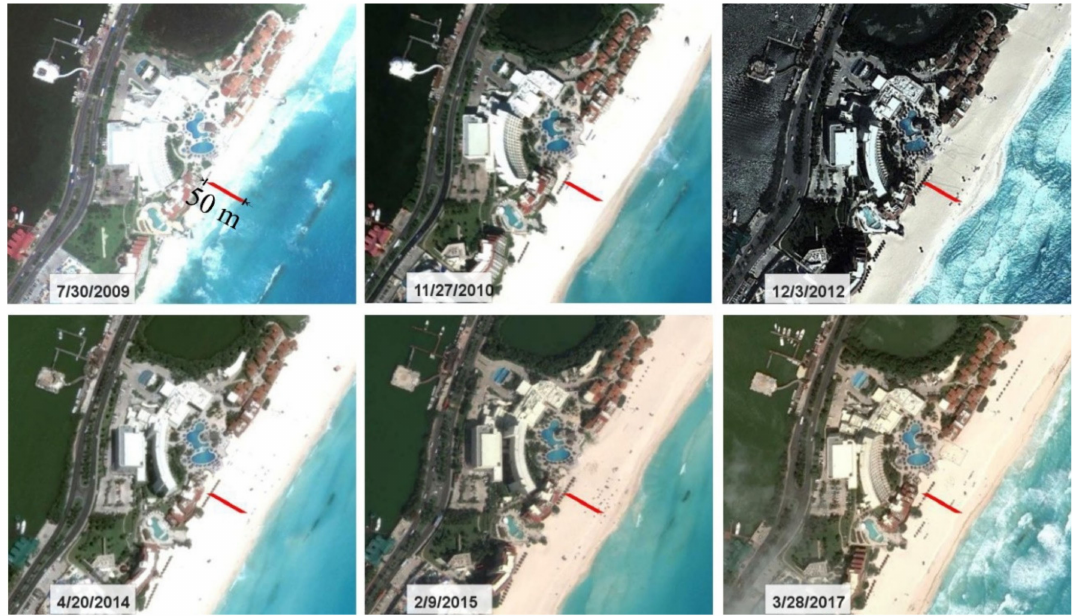
Figure 14. Satellite images, 2009 to 2017, of the beach in front of the Grand Park Royal Cancun, located in the central-north part of the beach (source: Google Earth Pro, version: 7.3.2.5776). The red line, 50 m long, shows the dynamic stability being reached.